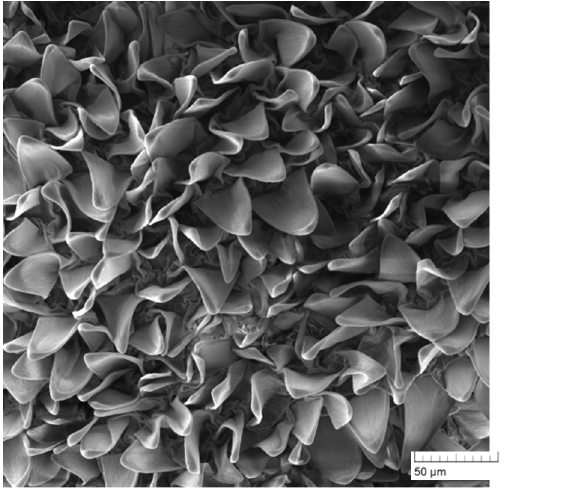
Figure 1. Garden pansy (Viola x wittrockiana) . ( a ) Photo of the crown petals of a garden pansy flower. ( b ) Image of the flower petal surface taken from a 3D microscope Zeiss Stemi DV4, magnification 32 times.